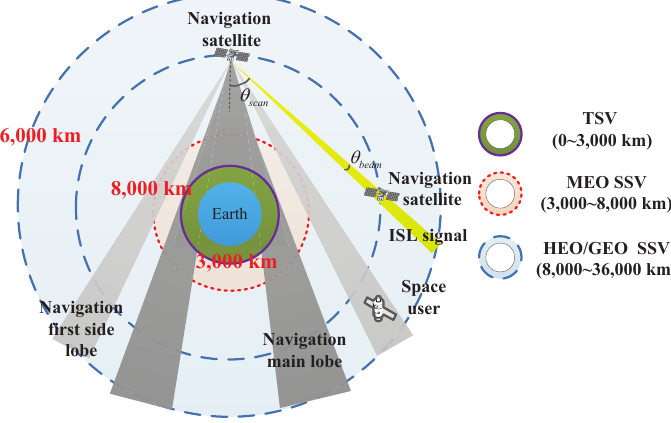
Figure 2. Coverage characteristics of navigation signal and ISL